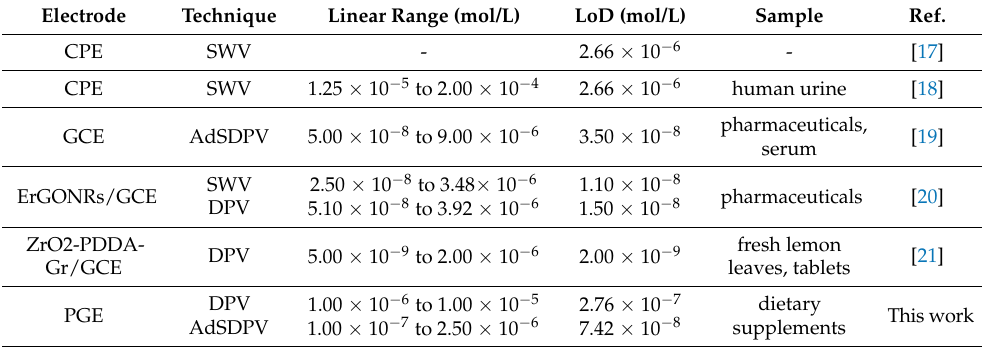
Table 3. The performance characteristics of voltammetric methods developed for the quantitative determination of DIO.